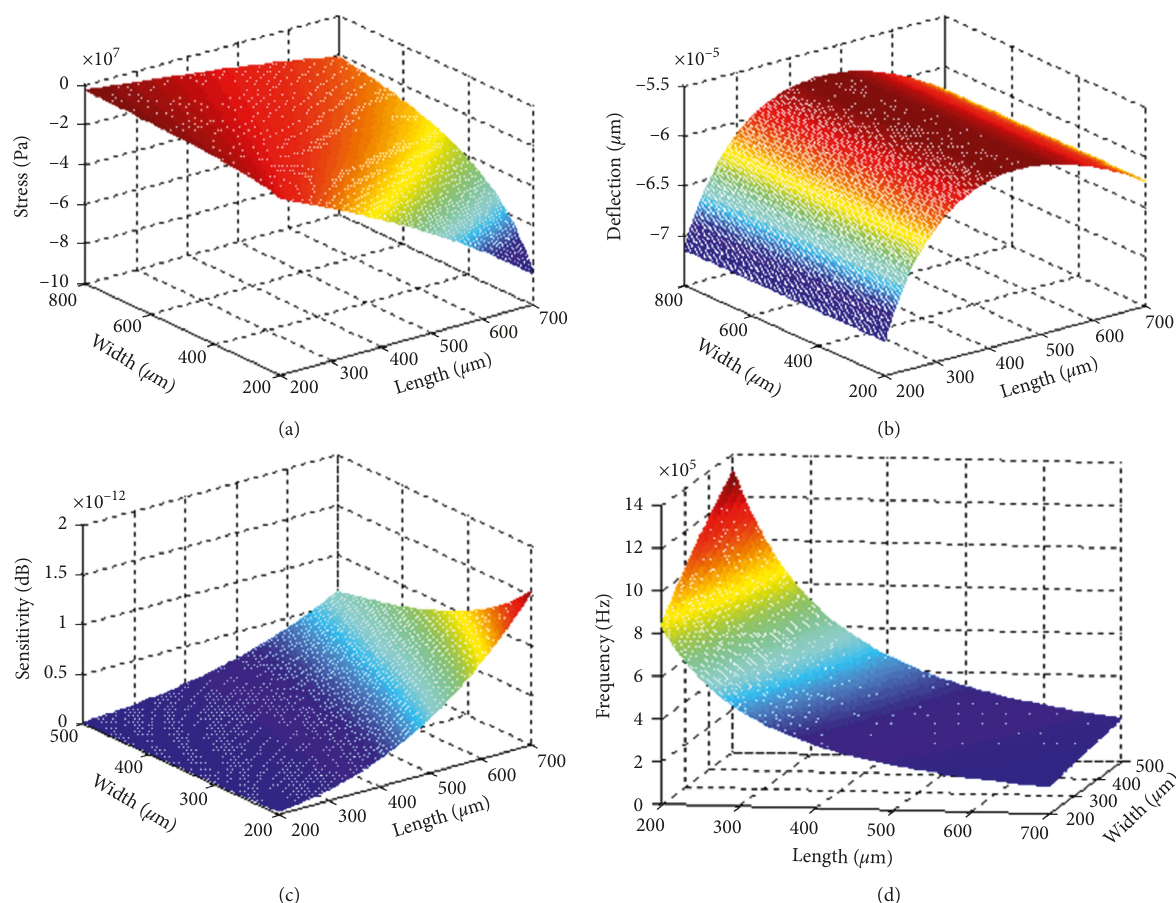
Figure 5: Characteristic diagram of the High-G MEMS accelerometer. (a) Stress. (b) Deflection. (c) Sensitivity. (d) Frequency.